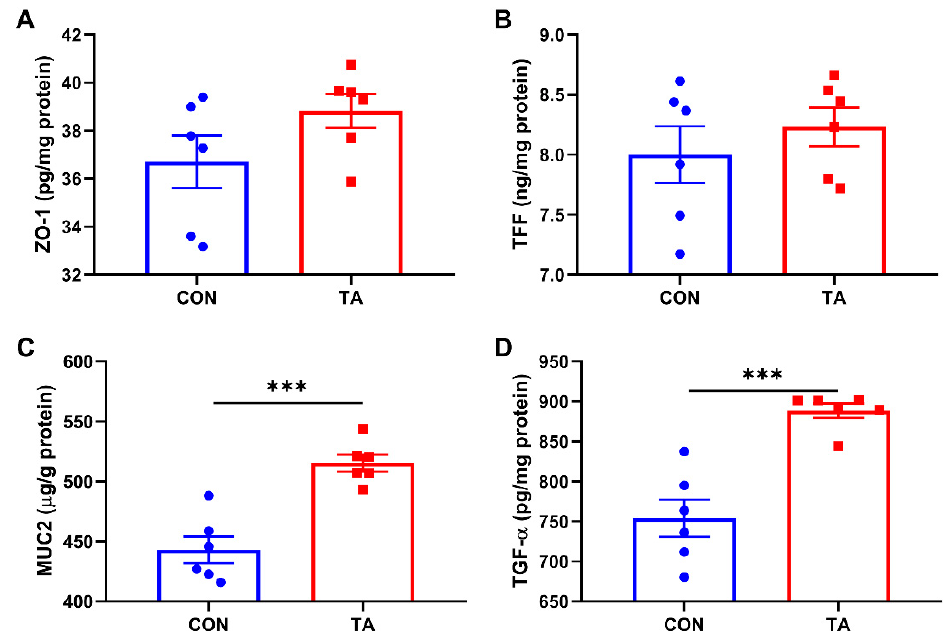
Figure 3. Effects of tannic acid extracted from Galla Chinensis supplementation on the maturity and integrity of intestinal mucosal barrier in broiler chickens. ( A ) Zonula occludens-1 (ZO-1); ( B ) Trefoil factor family (TFF); ( C ) Mucin 2 (MUC2); ( D ) Transforming growth factor- α (TGF- α ). CON, broiler chickens fed basal diet; TA, broiler chickens fed basal diet supplemented with 300 mg/kg microencapsulated tannic acid extracted from Galla Chinensis . Values are mean ± standard error ( n = 6). Differences between treatments were displayed by *** p < 0.001.